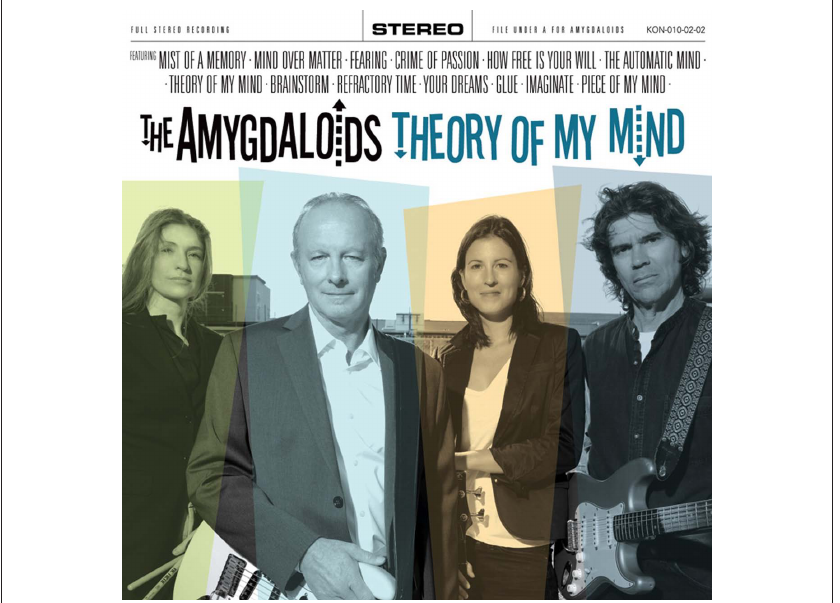
Figure 1 | The jacket cover of “Theory of My Mind” (released by Knock Out Noise,